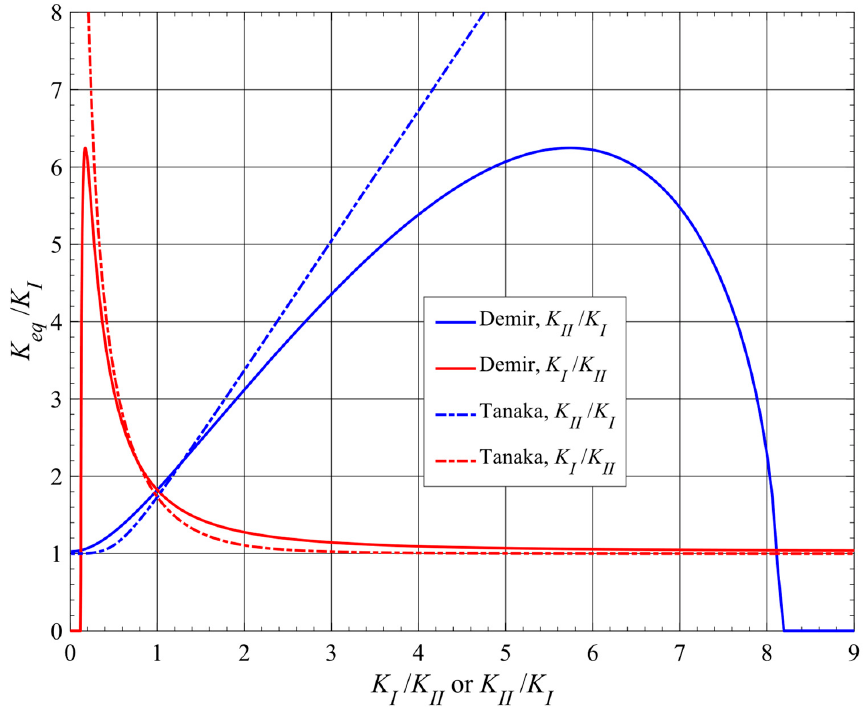
Figure 3. Demir’s K eq definition: illustration of the limitations of the approach. For comparison, Tanaka’s approach is also included.